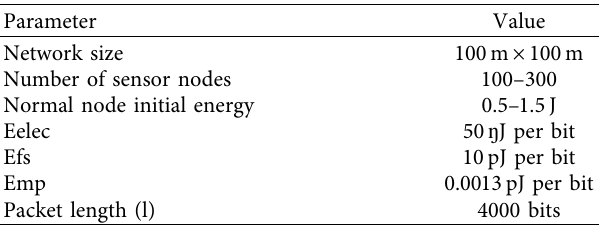
Table 1: Simulation parameter consideration.